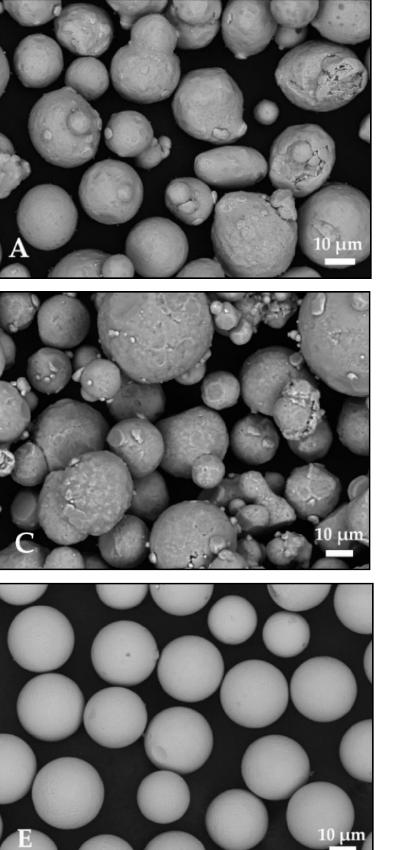
Figure 3. SEM micrograph of metallic alloy powders: ( A ) Fe-based 316L, ( B ) Ti-based Ti 6 Al 4 V, ( C ) Al-based AlSi 10 Mg, ( D ) Cu-based CuNi 2 SiCr, ( E ) Co-based CoCr 28 Mo 6 , and ( F ) Ni-based Inconel718.